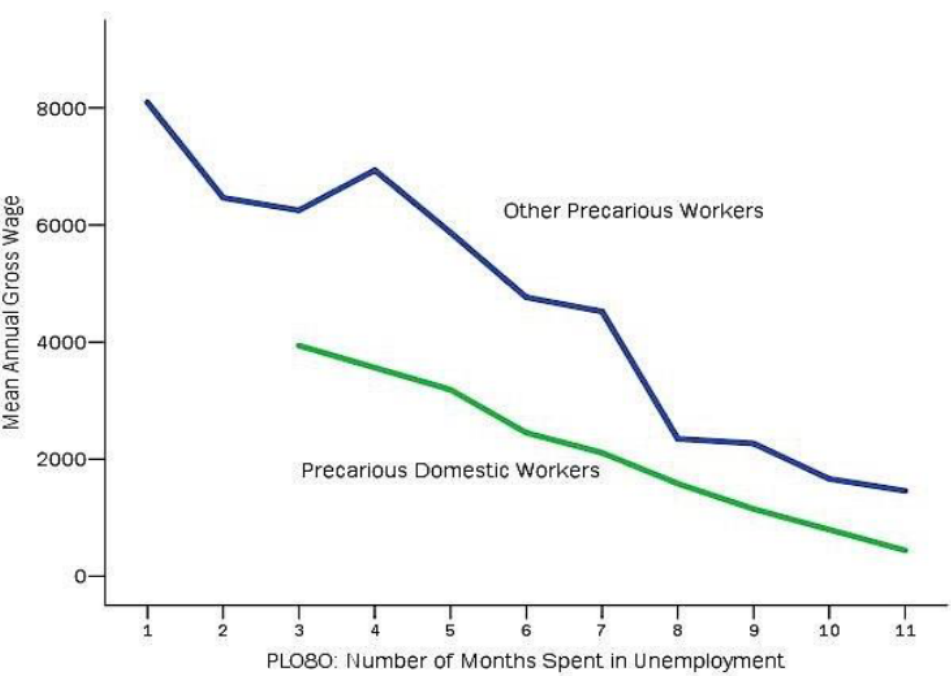
Figure 12. Annual gross labour income of precarious workers as a function of unemployment dura- tion (2019). Data source: EU-SILC (2020).